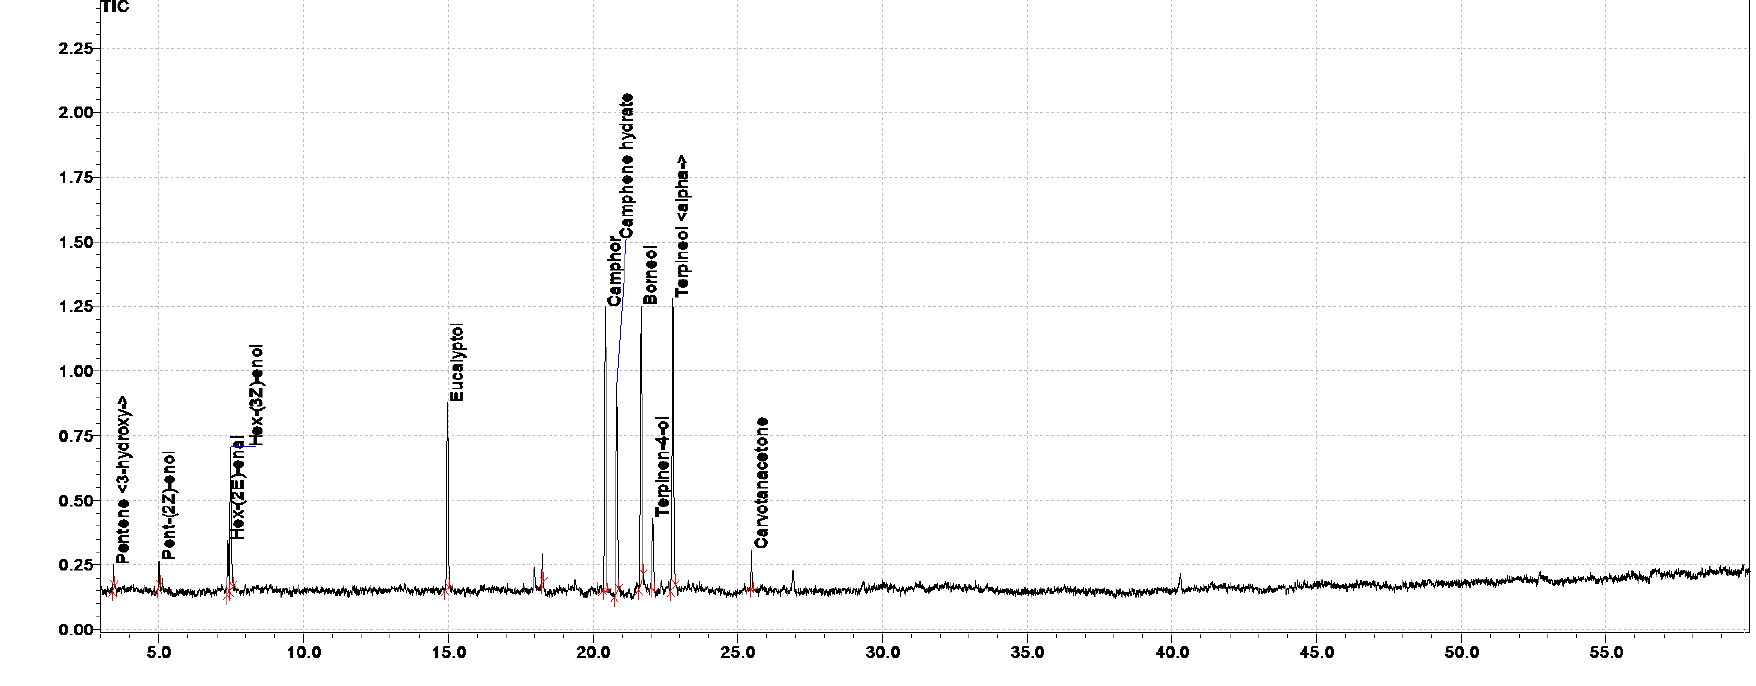
Figure A1. GC-MS chromatogram of hydrosol obtained from Picea abies (Bele vode, avg.